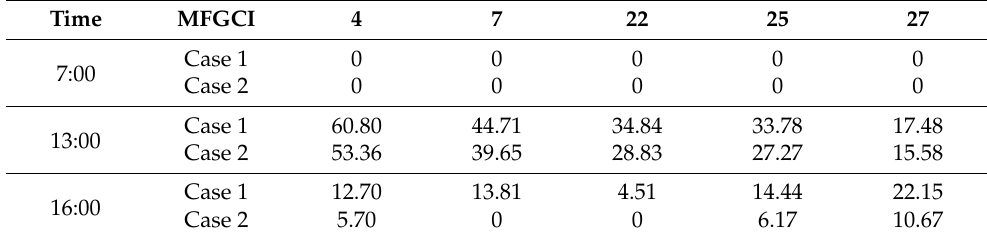
Table 13. Comparison of active power reduction by MFGCI (kW).